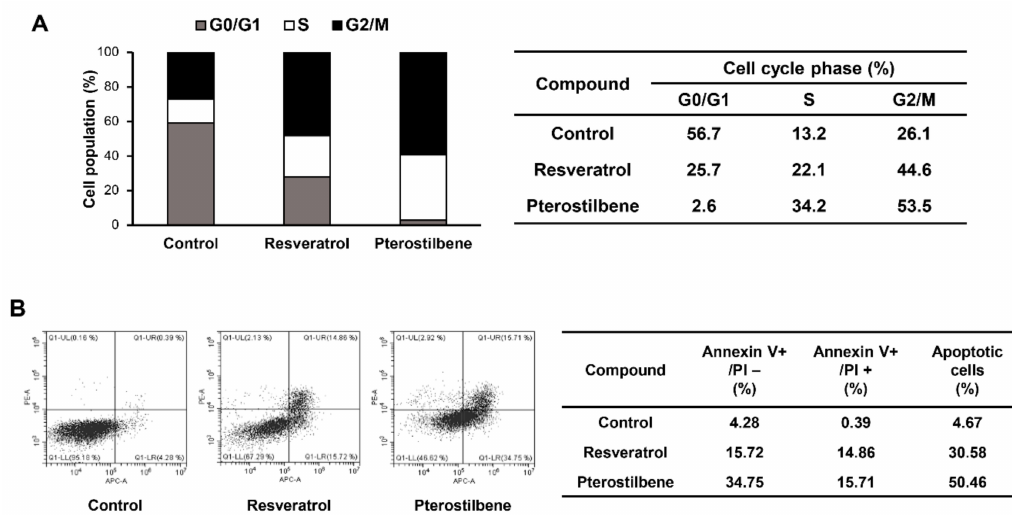
Figure 4. E ff ects of resveratrol and pterostilbene on the cell cycle and apoptotic cell death of HeLa cells. ( A ) The cell cycle distribution of HeLa adherent cells was evaluated by flow cytometry after the treatment of the two compounds (40 µ M) for 48 h. ( B ) HeLa adherent cells were treated with resveratrol and pterostilbene (40 µ M) for 48 h. Apoptotic cells were determined by flow cytometry analysis following annexin V-FITC and propidium iodide (PI) dual